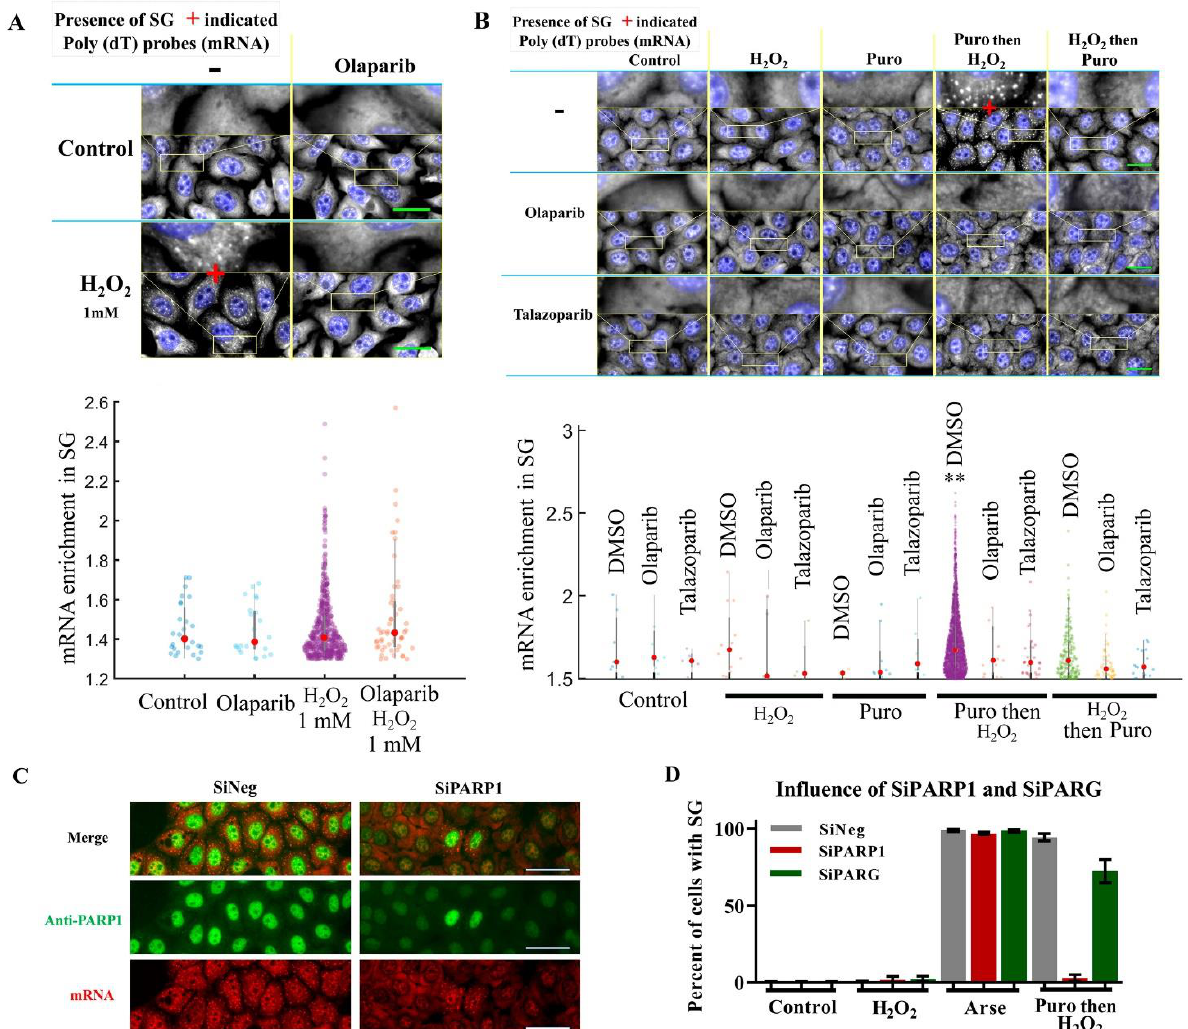
Figure 2. After polysome destabilization by puromycin, PARP1 activation triggers SG assembly. ( A ) HeLa cells were exposed to a high H 2 O 2 concentration (1 mM for 1 h) to trigger SG assembly. Blue: DAPI (nuclei). Grey: mRNA (in situ hybridization with cy3-labelled poly(dT) probe). Lower panel: the number of SGs detected after cells were exposed to 1 mM H 2 O 2 decreased sharply when cells were pretreated with olaparib (10 μM). Scale bar: 10 μm. Red dots represent the mean value of the data. ( B ) HeLa cells were exposed to indicated treatments (300 µM H 2 O 2 for 30 min; 200 µM puromycin 60 min). DMSO (control), 10 µM olaparib and 1 µM talazoparib were added 1 h prior to indicated treatments to inhibit PARP1. mRNA was then detected to reveal the presence of SG sin the cytoplasm. Blue: DAPI (nuclei). Grey: mRNA (in situ hybridization with cy3-labelled poly(dT) probe). Scale bar: 10 μm. Lower panel: mRNA enrichment in detected SGs. **, p < 0.001; t test. ( C ) HeLa cells were treated with siRNA-directed mRNA encoding PARP1 and then exposed to indicated treatments. Green: anti-PARP1 antibody. Red: mRNA (in situ hybridization with cy3-labelled poly(dT) probe). Scale bar: 10 μm. ( D ) Percent of cells displaying SGs after pretreatments indicated in ( B ).